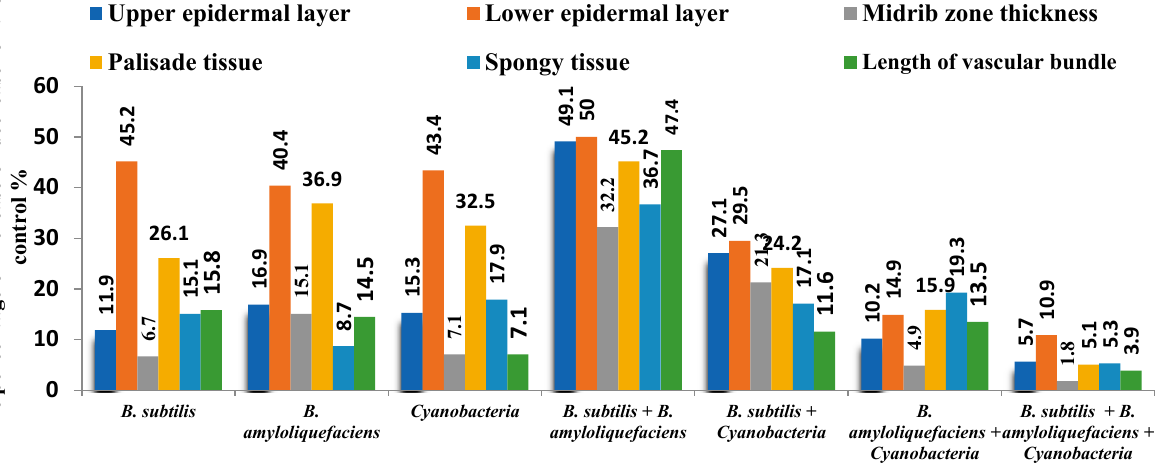
Figure 3. Effect of plant growth promoting rhizobacteria (PGPR) and cyanobacteria on the terminal leaflet characteristics of tomato as comparing to the untreated plants (control).